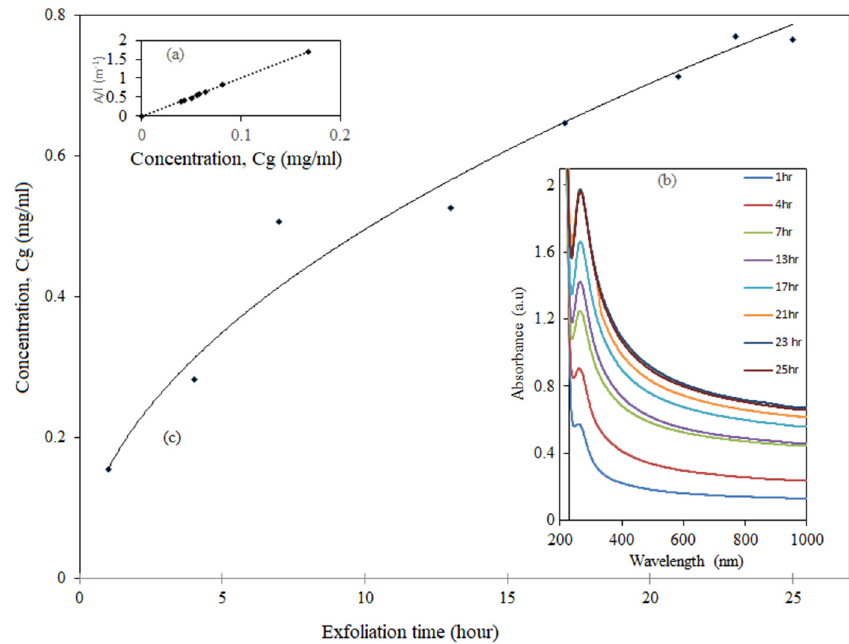
Figure 2. ( a ) Absorbance per unit path length ( λ = 660 nm), A/l, as a function of the concentration of graphene, Cg, in water/acetone mixtures (75-wt % acetone). The graph follows Lambert–Beer behavior, with an absorption coefficient of α = 1013 mL mg − 1 m − 1 . ( b ) UV-vis absorption spectra for different sonication times. ( c ) Sonication times vs. concentration graph with centrifugation frequency of 1500 rpm for half an hour, followed by another centrifugation with a frequency of 3000 rpm for another half an hour; 0.2 mL graphene dispersion was mixed with 5 mL water. After 1 h sonication, dark black graphene dispersions were achieved. The UV-vis